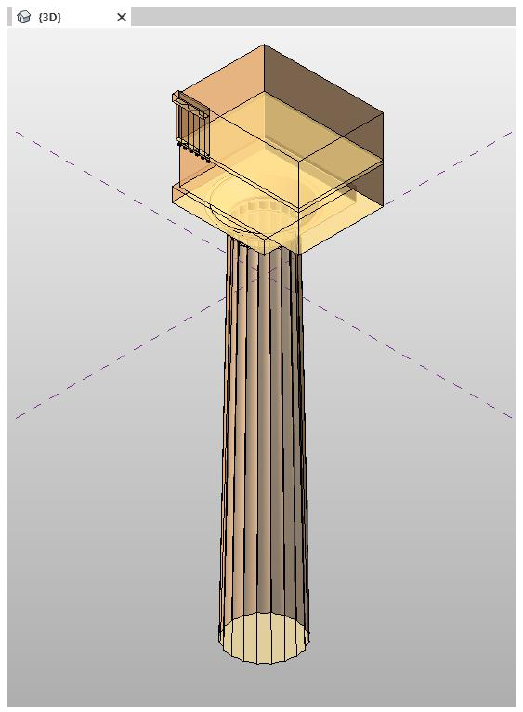
Figure 3 . The three-dimensional model of Doric column. (source: Kontoudaki, 2021.)